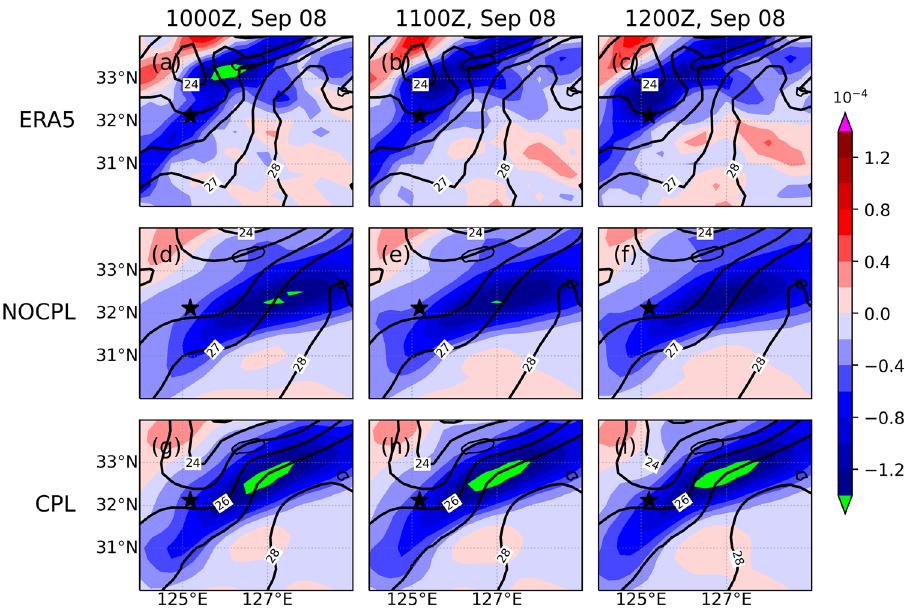
Figure 7. Same as Fig. 6 but for meridional gradient of 1000-hPa equivalent potential temperature (10 –4 K/m; shaded) and sea surface temperature (°C;